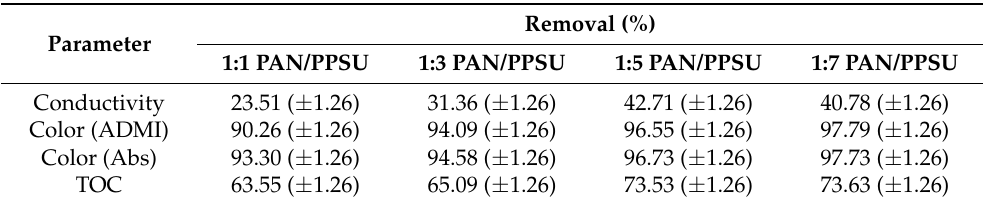
Table 4. Comparison between the separation performances of TFC NF membranes in the AT-POME treatment under pressure-driven mode.